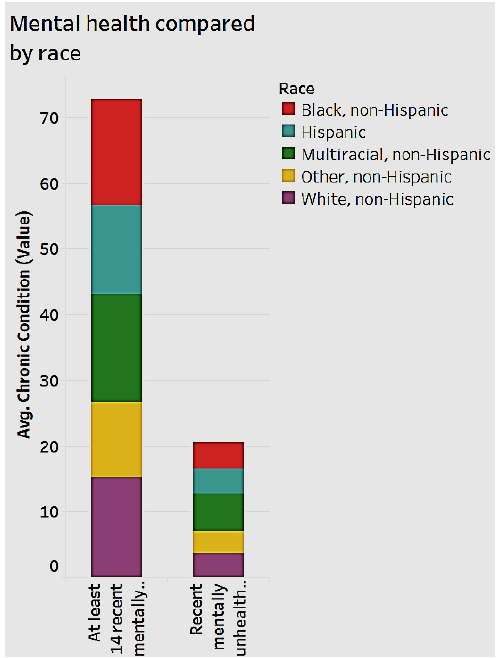
Figure 9. Mental health by race.